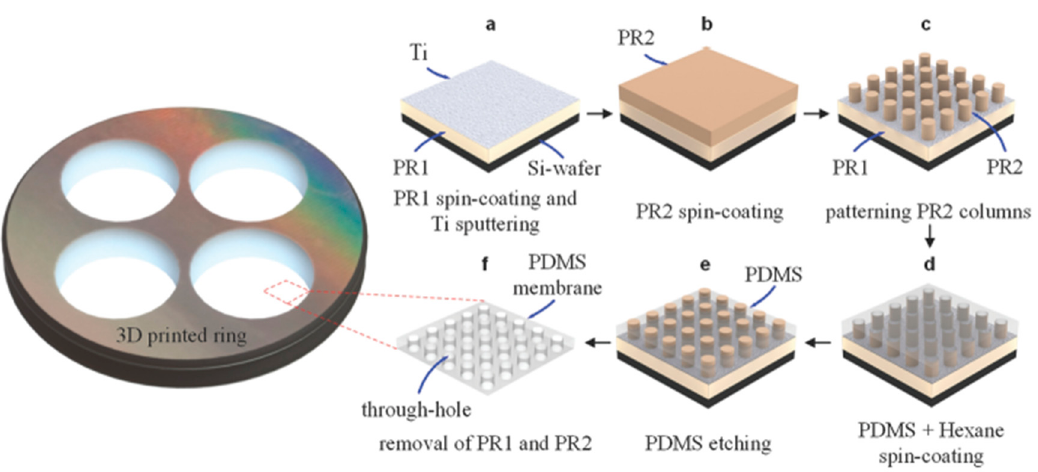
Figure 17. Fabrication process of a free-standing and sub- µ m thick PDMS through-hole membrane. Photoresist (PR) layer (OiR 907-17i, Fujifilm, Japan) of 1.71 ± 0.04 µ m in thickness is used as the sacrificial layer. Si wafer (525 µ m thick, Okmetic, Finland) is used as a support base, adapted from [34] .